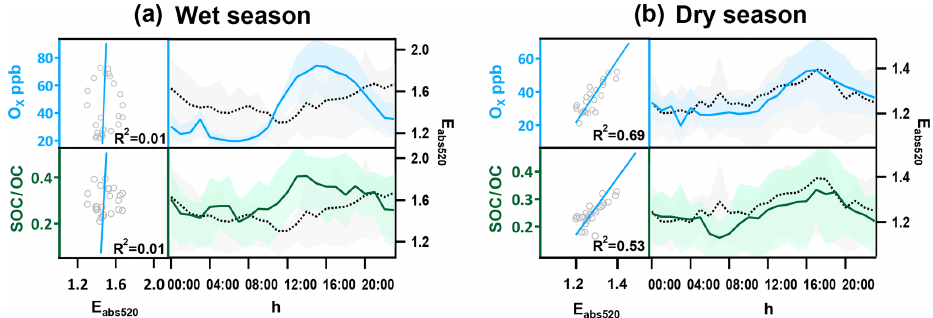
Figure 4. The effect of the secondary process on E abs520 . (a) Diurnal pattern of E abs520 and O x in the wet season. The lines (O x in blue, SOC / OC in green and E abs520 in dotted black lines) represent hourly averages and the shaded areas represent 25th and 75th percentiles. (b) Same as (a) but in the dry season.